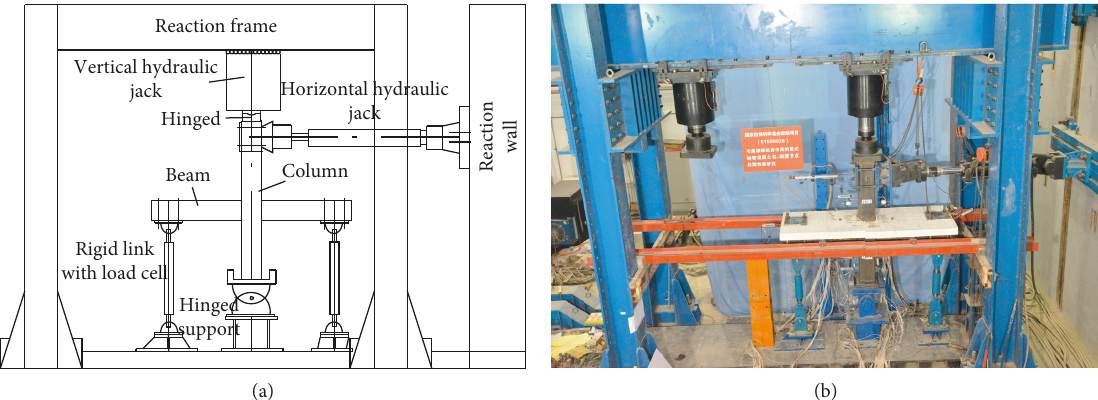
Figure 5: Test setup: (a) diagram of the loading device; (b) photograph of the loading device.